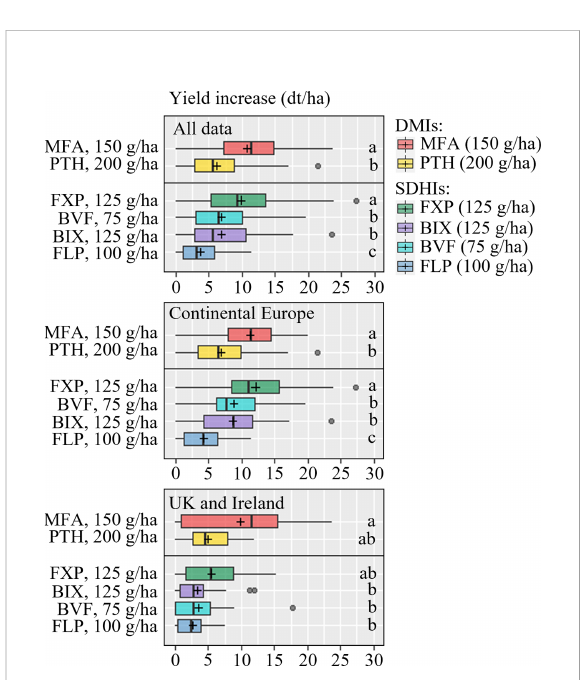
FIGURE 6 Yield increases from 21 fi eld trials with the azoles mefentri fl uconazole (MFA), prothioconazole (PTH) and the SDHIs fl uxapyroxad (FXP), bixafen (BIX), fl uopyram (FLP) and benzovindi fl upyr (BVF). Trials from Continental Europe were carried out in Denmark (DK), France (FR), Germany (DE), Poland (PL) and Belgium (BE). FLP was not included in 2021. The line inside the boxes indicates the median and ‘ + ’ indicates the average. Different letters represent signi fi cant differences between treatments within boxplot as determined by Dunn ’ s